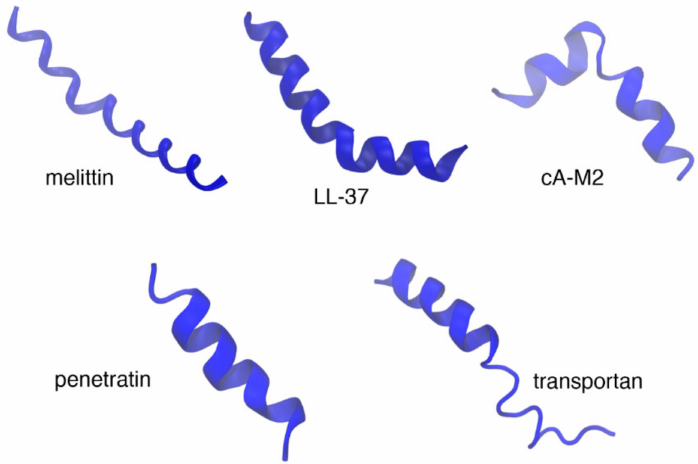
Figure 2. Examples of α -helical antimicrobial peptides (AMPs) (top panel) and cell-penetrating peptides (CPPs) (bottom panel). Top panel shows the X-ray crystal structure of melittin (2mlt), solution structure of LL-37 (cathelicidin) in deuterated sodium dodecyl sulfate (dSDS) micelles (2k6o) [34], and the solution structure cecropin A(1-8)–magainin 2(1-12) hybrid peptides (1d9j) [35]. The solution structures of CPPs penetratin in negatively charged phospholipid bicelles (1omq) [36] and transportan in neutral phospholipid bicelles (1smz) [37] are shown in the bottom panel.